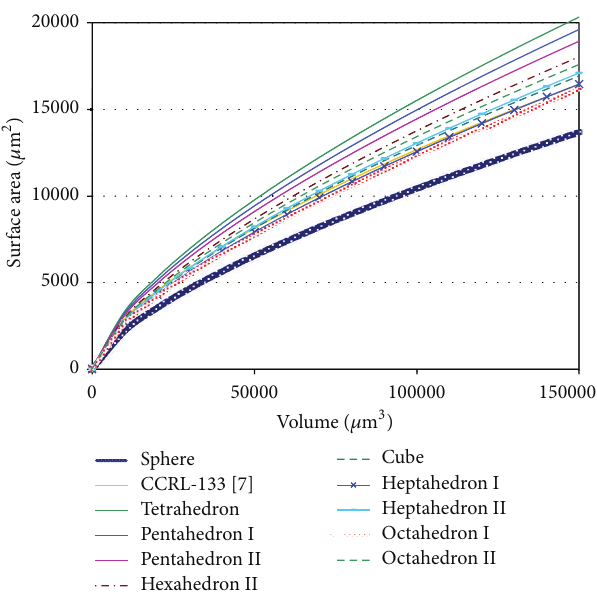
Figure 5: 𝑆 - 𝑉 curves of reference cement and some regular